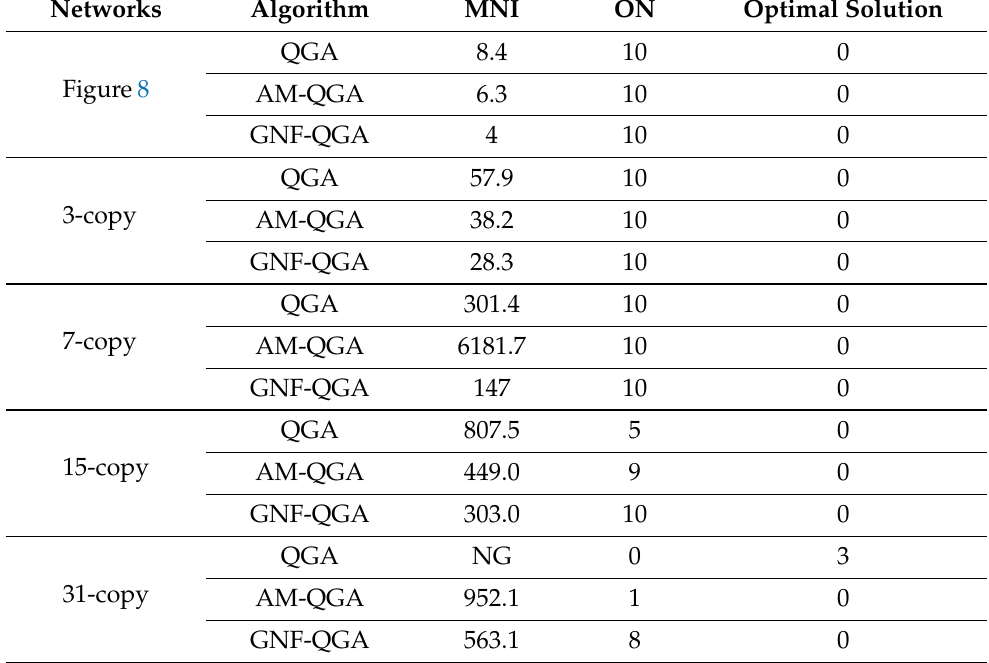
Table 5. Experiment